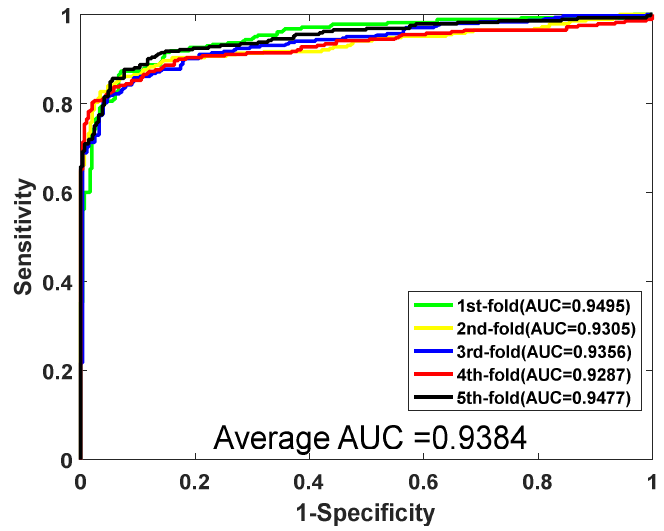
Figure 5. The ROC curve of the SVM classifier on the H. pylori dataset.